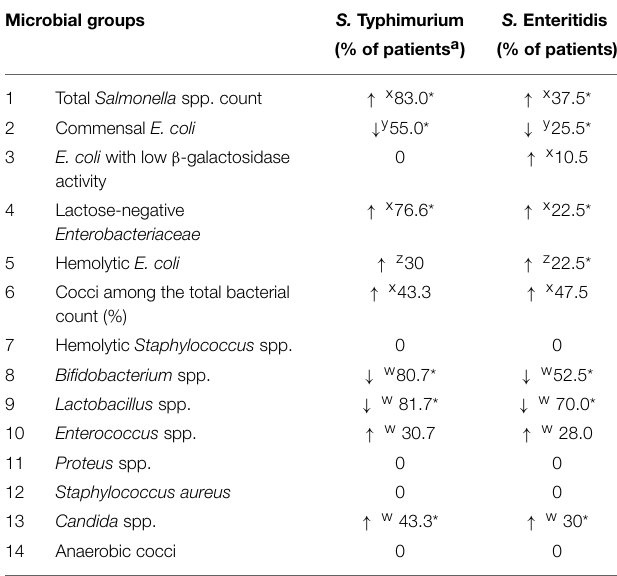
TABLE 1 | Dysbiotic changes due to S. Typhimurium and S. Enteritidis infections. Microbial